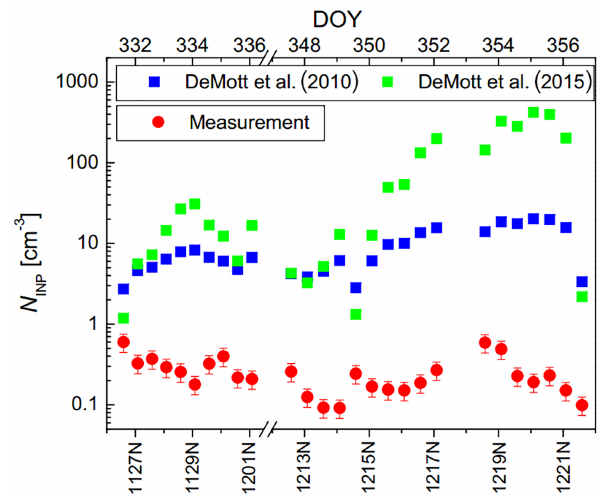
Figure 7. The time series of measured N INP and N INP parameter- ized according to DeMott et al. (2010, 2015) at − 16 ◦ C.